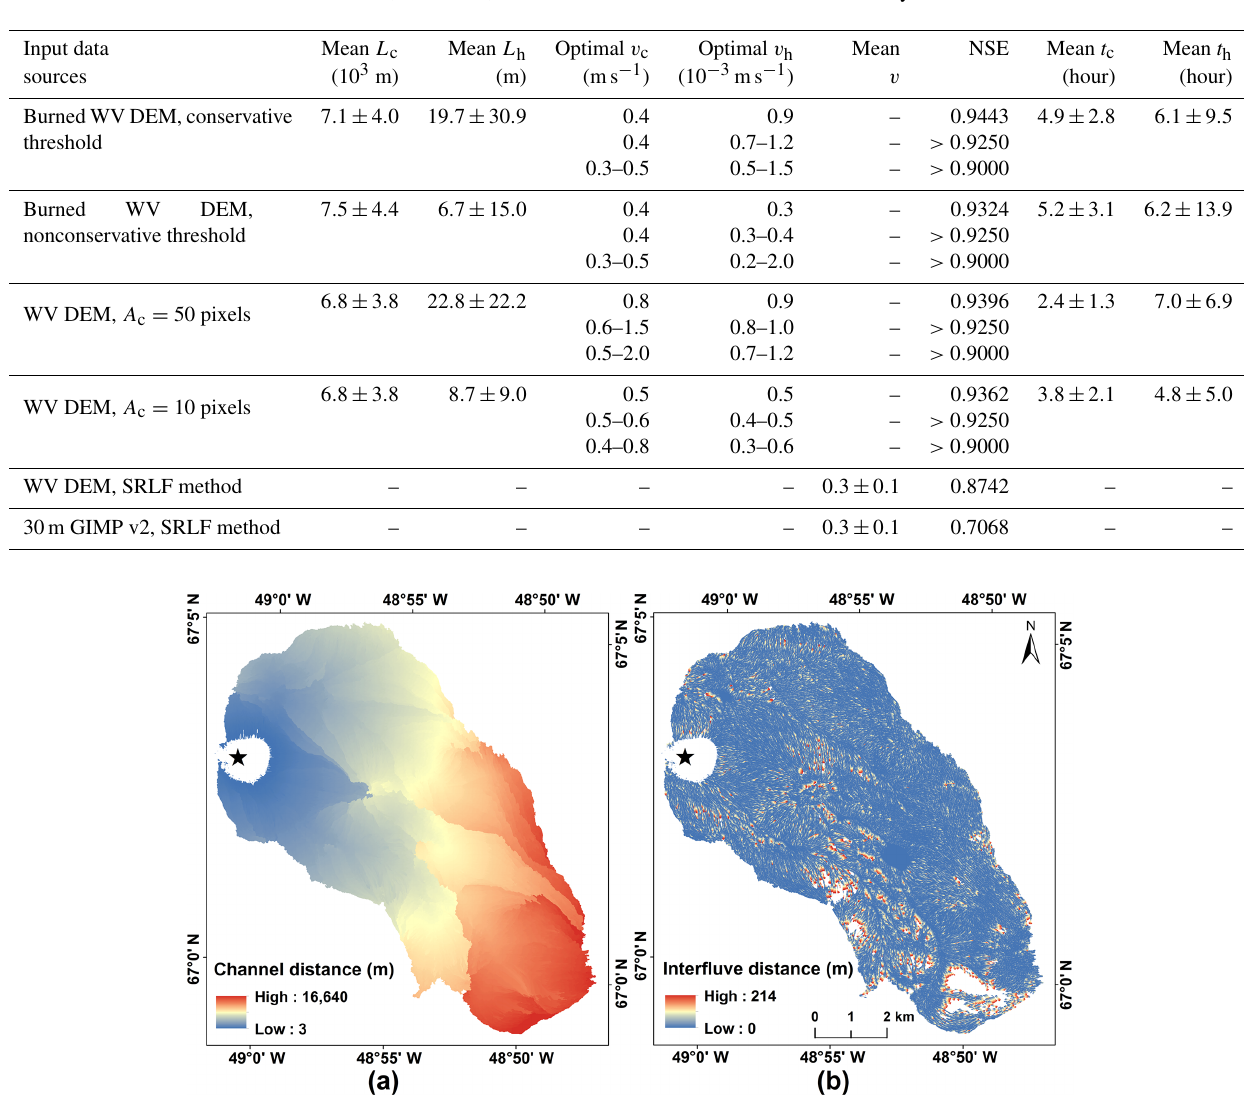
Figure 4. Meltwater travel distances for (a) open channels and (b) interfluves of the Rio Behar internally drained catchment (IDC) as obtained by burning the 18 July 2015 WorldView DEM with the conservative remotely sensed active supraglacial stream–river surface drainage